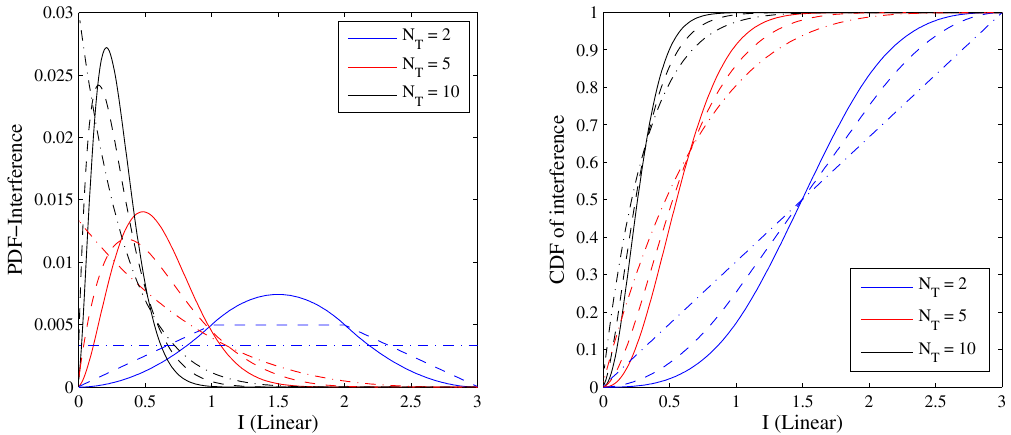
Figure 6. Effect of interferer precoder variation in multiantenna system. Left: PDF of realized interference power due to precoder variation for J = 3 interferers; Right: CDF of realized interference power. Dash-dot line- J = 1, dashed line- J = 2 and solid line- J = 3.